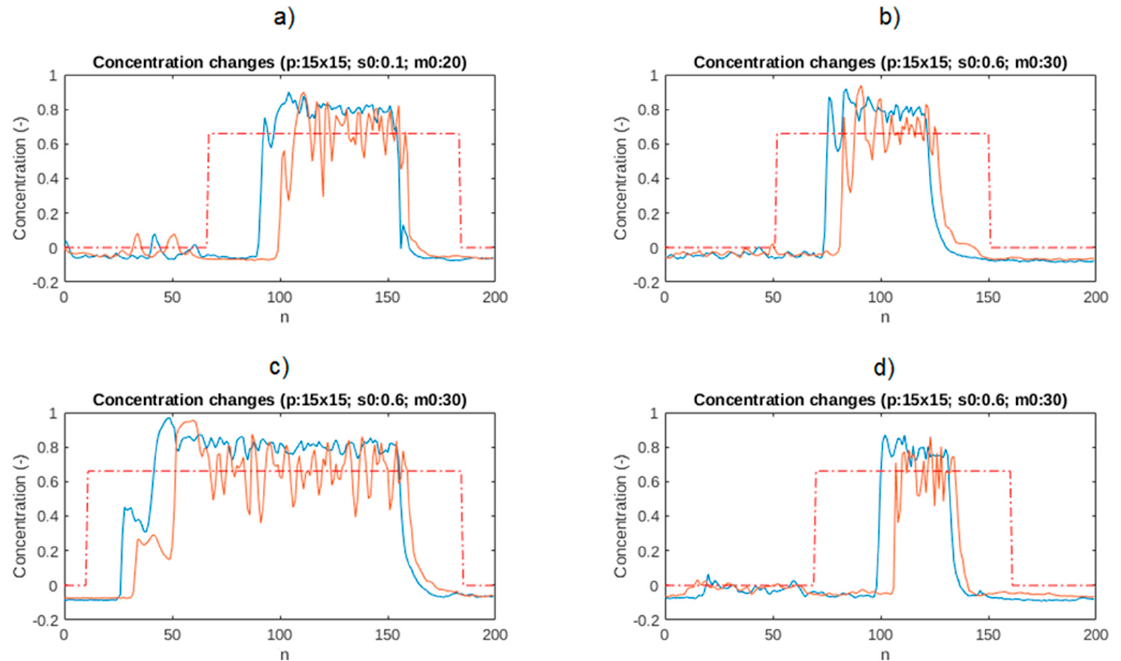
Figure 7. Plug identification algorithm output for several cases. The signal from the second plane is presented with an orange color. The dotted lines present ranges of computed patterns: ( a ) Shows patterns where s 0 = 0.1 and m 0 = 20; ( b – d ) shows patterns with s 0 = 0.6 and m 0 = 30.